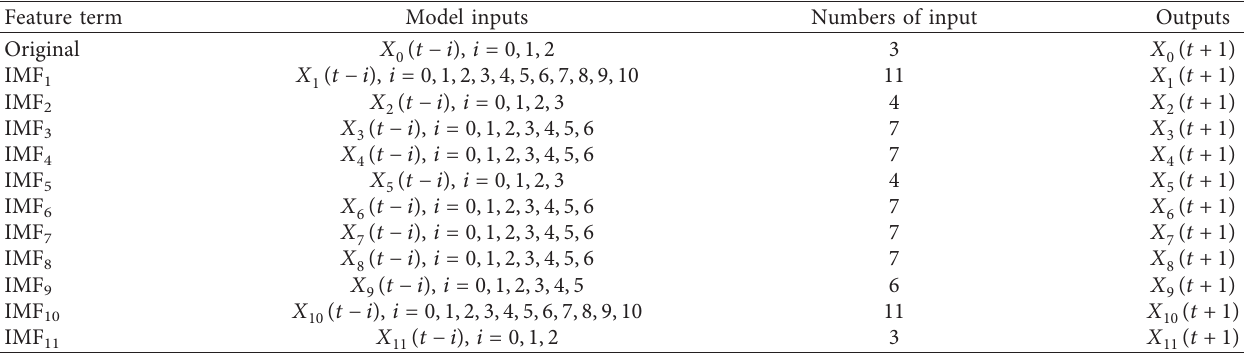
Table 2: The input features and output targets for the VMD decomposition sequences of the raw data and its decomposition sequences at the Weijiabao station.